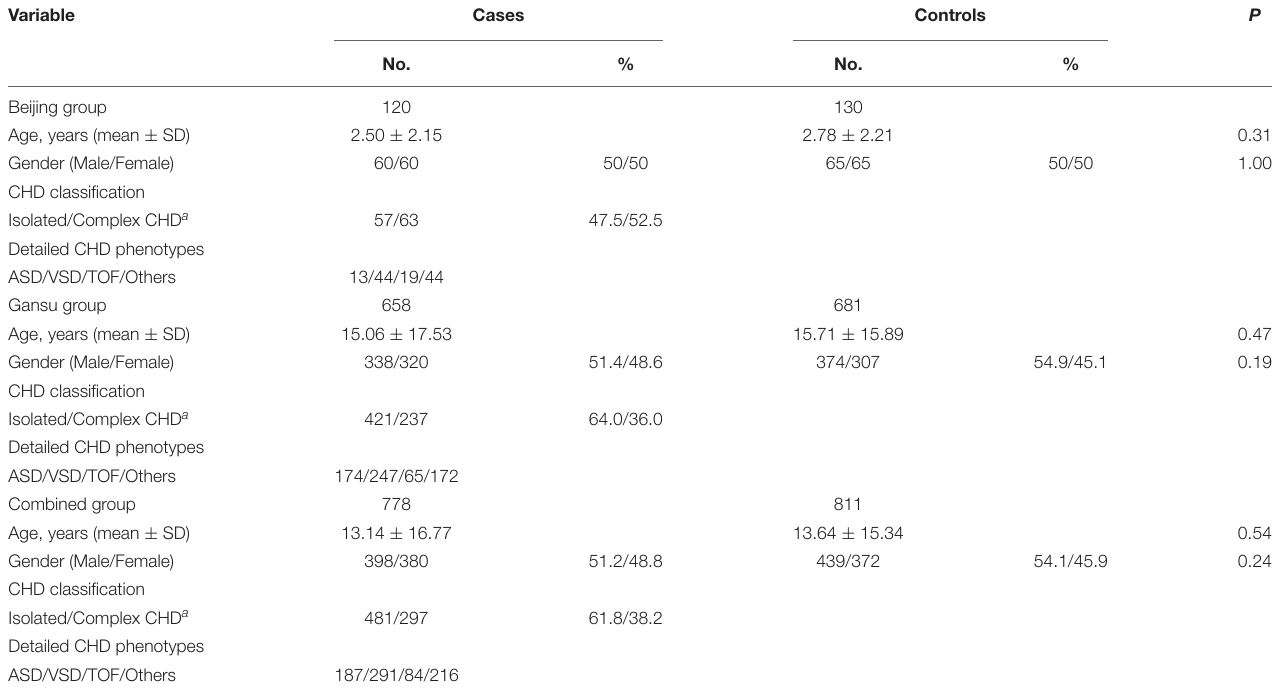
TABLE 1 | Clinical characteristics in CHD cases and controls.